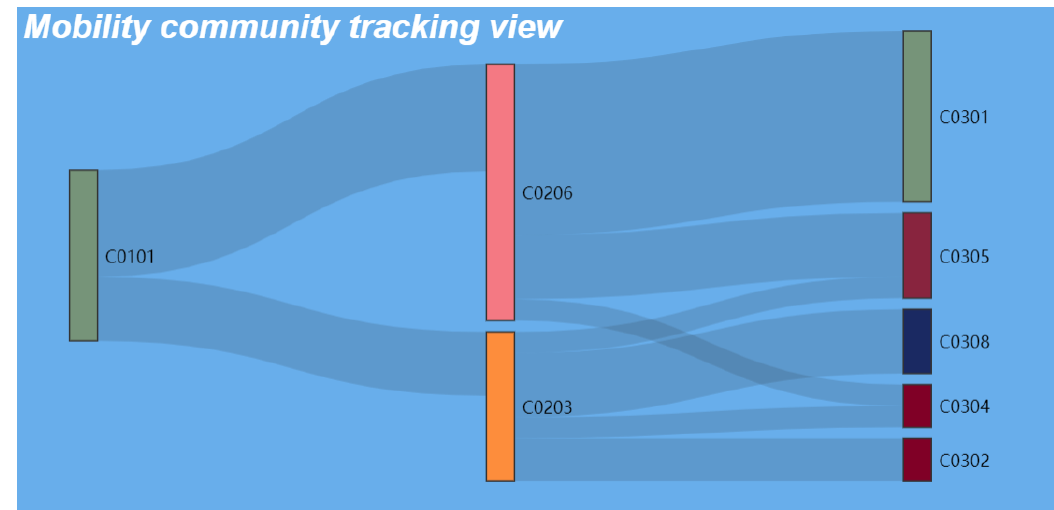
Figure 4. Mobility community tracking view. We can observe that the selected community “C0101” (indicating a detected community on April 1) has a significant number of transit trips connecting it and two communities on April 2 (“C0206” and “C0203”). These two are further connected with five communities (C0301, C0302, C0304, C0305, and C0308) on April 3. We can see that “C0101” is strongly connected with “C0206” and “C0301”, as indicated by the width of ribbons between these communities.